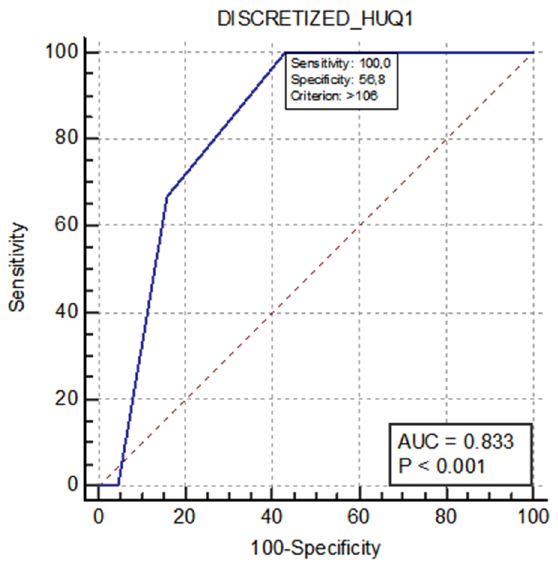
Figure 4. ROC curve for the prediction of NRAS mutations based on the discretized HU Figure 3. ROC curve for the prediction of NRAS mutations based on the discretized HU Q1. Table 3. Microsatellite status—significant parameters.